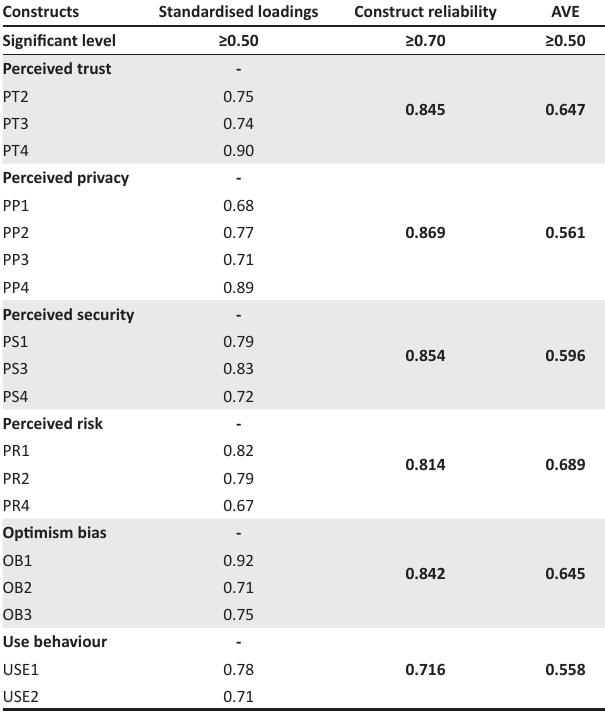
TABLE 1: Reliability results.